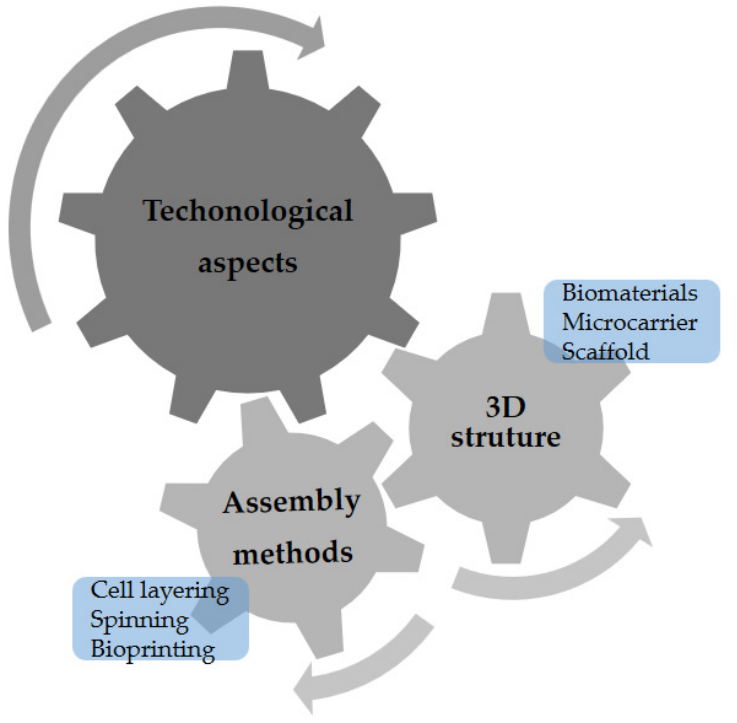
Figure 2. The technological aspects that must be considered for cultivated meat production. Tissue construction aiming at successful recreation must mimic an extracellular matrix (ECM), including the composition, the physical properties and the technique for building a structure, all of which will affect the mechanical characteristics of the generated tissue [66]. types of scaffolds can provide different cell targeting and differentiation outcomes [67].